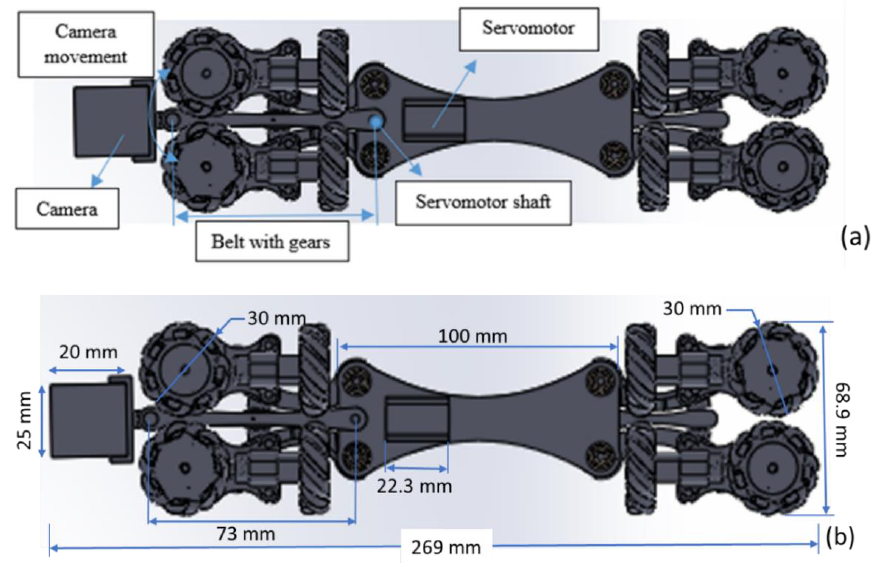
Figure 7. Components of the proposed pipe robot ( a ) Servomotors and camera position. ( b ) Robot dimensions.